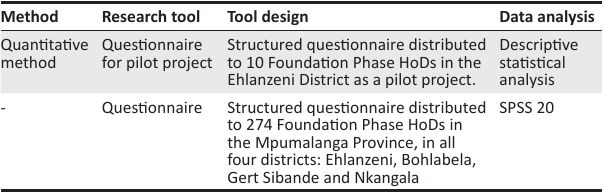
TABLE 1: Research methods used in this research